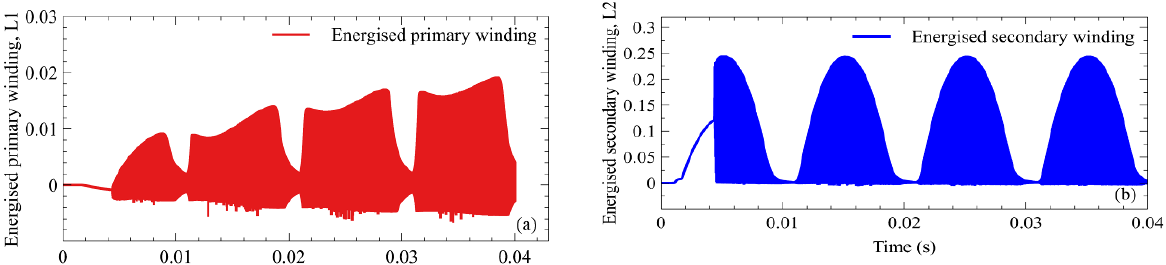
Figure 7. Energised windings (i.e., Modes 4 – 5): ( a ) Primary and ( b ) secondary.